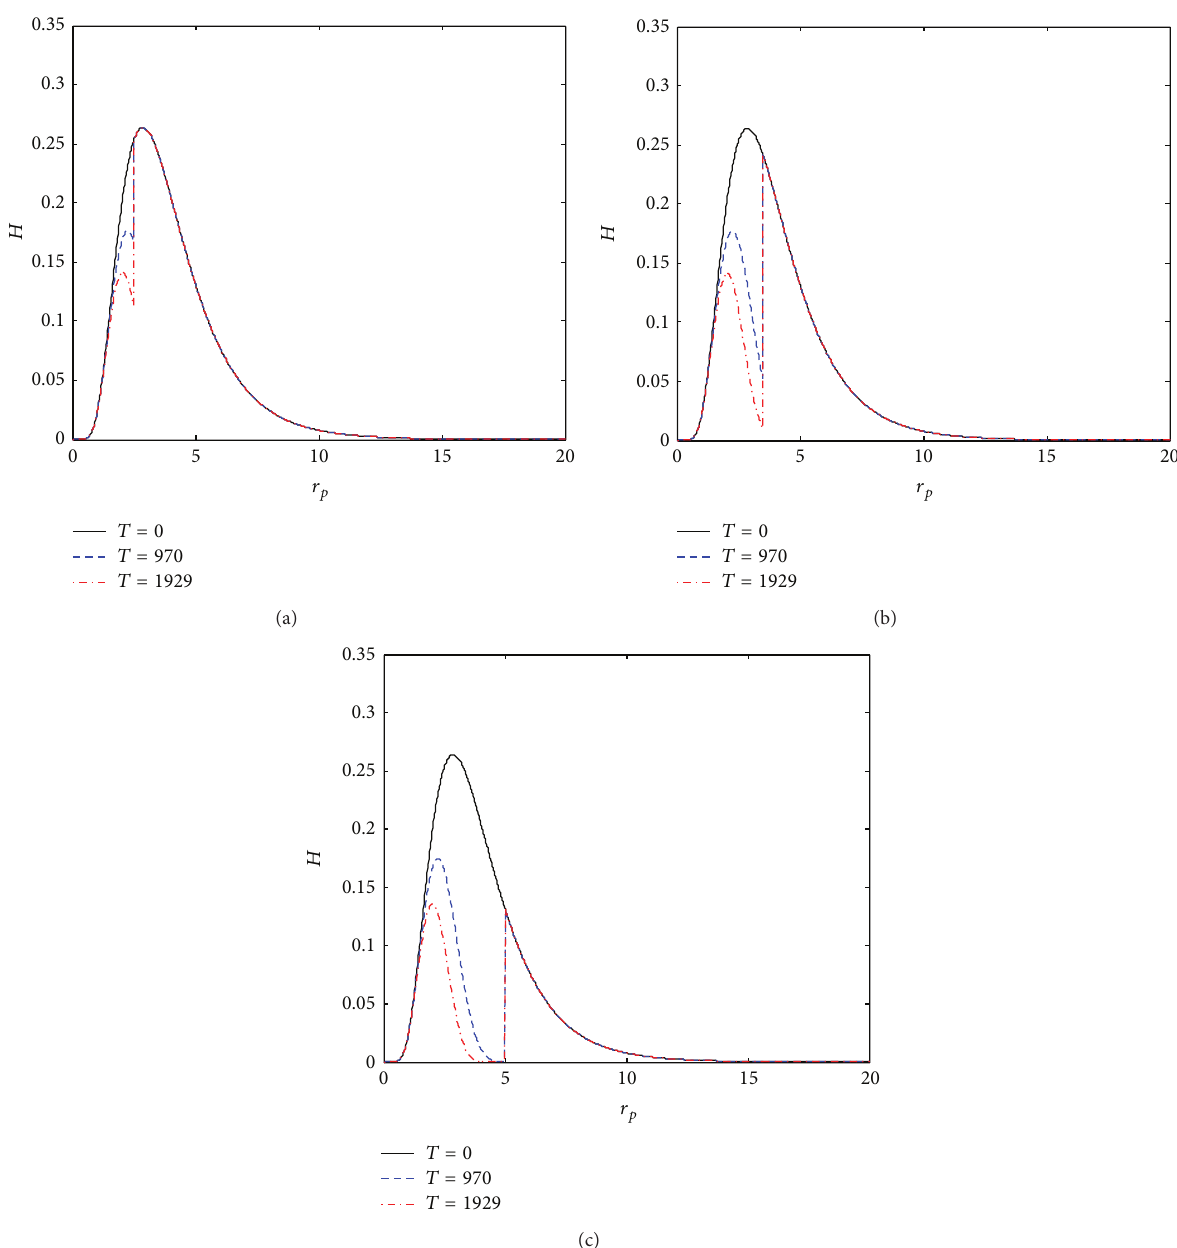
Figure 5: Evolution of the pore size distribution for different sizes of injected particles: (a) r 𝑠 = 2.5 𝜇 m; (b) r 𝑠 = 3.5 𝜇 m; (c) r 𝑠 = 5.0 𝜇 m.